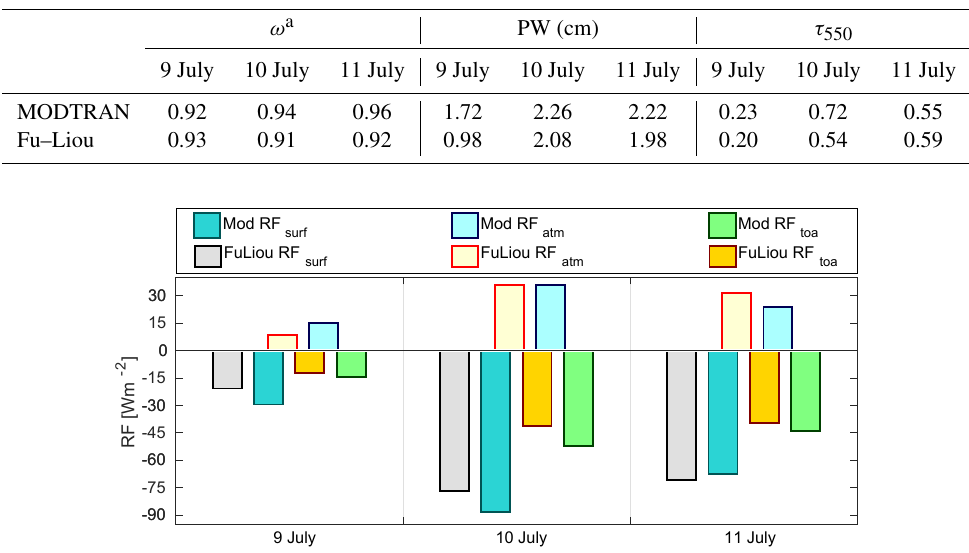
Table 2. The mean daily values of the single-scattering albedo ω a , precipitable water PW (cm), and aerosol optical depth τ 550 at 550nm used as inputs to MODTRAN and Fu–Liou simulations.